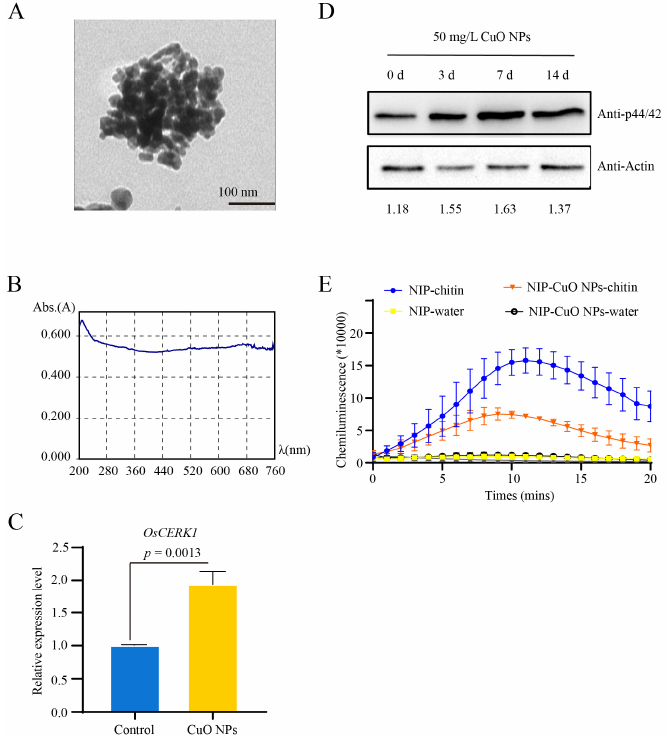
Figure 1. The well-known receptor kinase gene OsCERK1 responds to CuO NPs stress in rice. ( A ) Characterization of the CuO NPs used in this study. ( B ) The absorption spectrum of the CuO NPs suspension. The absorption peak was about 210 nm. ( C ) Transcript abundance of OsCERK1 in the rice seedlings treated with CuO NPs. ( D ) The MAPKs activities in the rice seedlings treated with CuO NPs were higher than those of the control. The total proteins were extracted from Nipponbare (NIP) seedlings treated with CuO NPs at 3, 7, and 14 days to perform western blot assay with anti-phospho-p44/42 anti-body. The relative intensities of the blots were quantified by ImageJ with actin as an internal control. ( E ) Reactive oxygen species (ROS) generation was effectively induced by chitin in the CuO NPs treated rice seedlings. The bars are shown as means ± SD of three replications. The student’s t -test was used to analyze the data and generate p